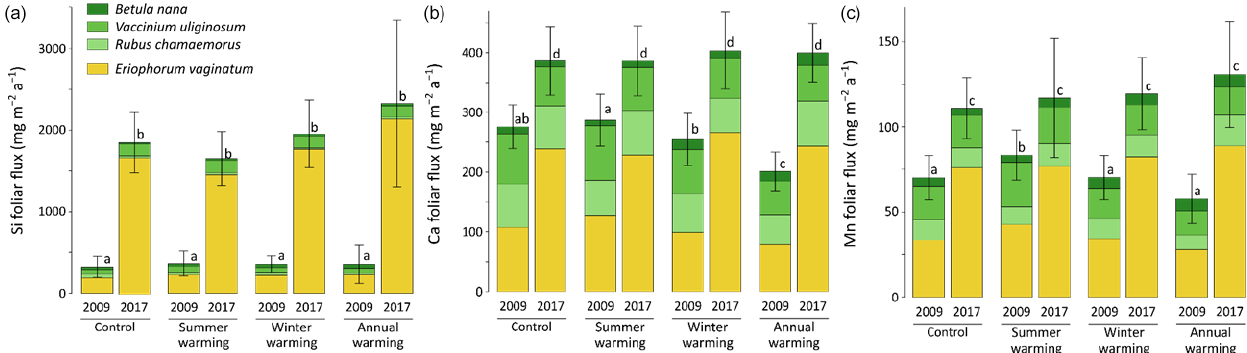
Figure 6. Evolution over time of the cumulative annual foliar fluxes (mgm − 2 a − 1 ) of (a) silicon, (b) calcium, and (c) manganese for the considered species between the four warming treatments of the experimental site (CiPEHR). Vegetation is sorted by plant functional types: deciduous shrubs and forbs (green) and sedges (yellow). The four treatments (control, summer warming, winter warming, and annual warming) refer to no artificial treatment, air warming, soil warming, and both air and soil warming, respectively. Letters correspond to a mixed-effect model analysis and compare total foliar elemental fluxes between warming treatments and years. Error bars represent standard